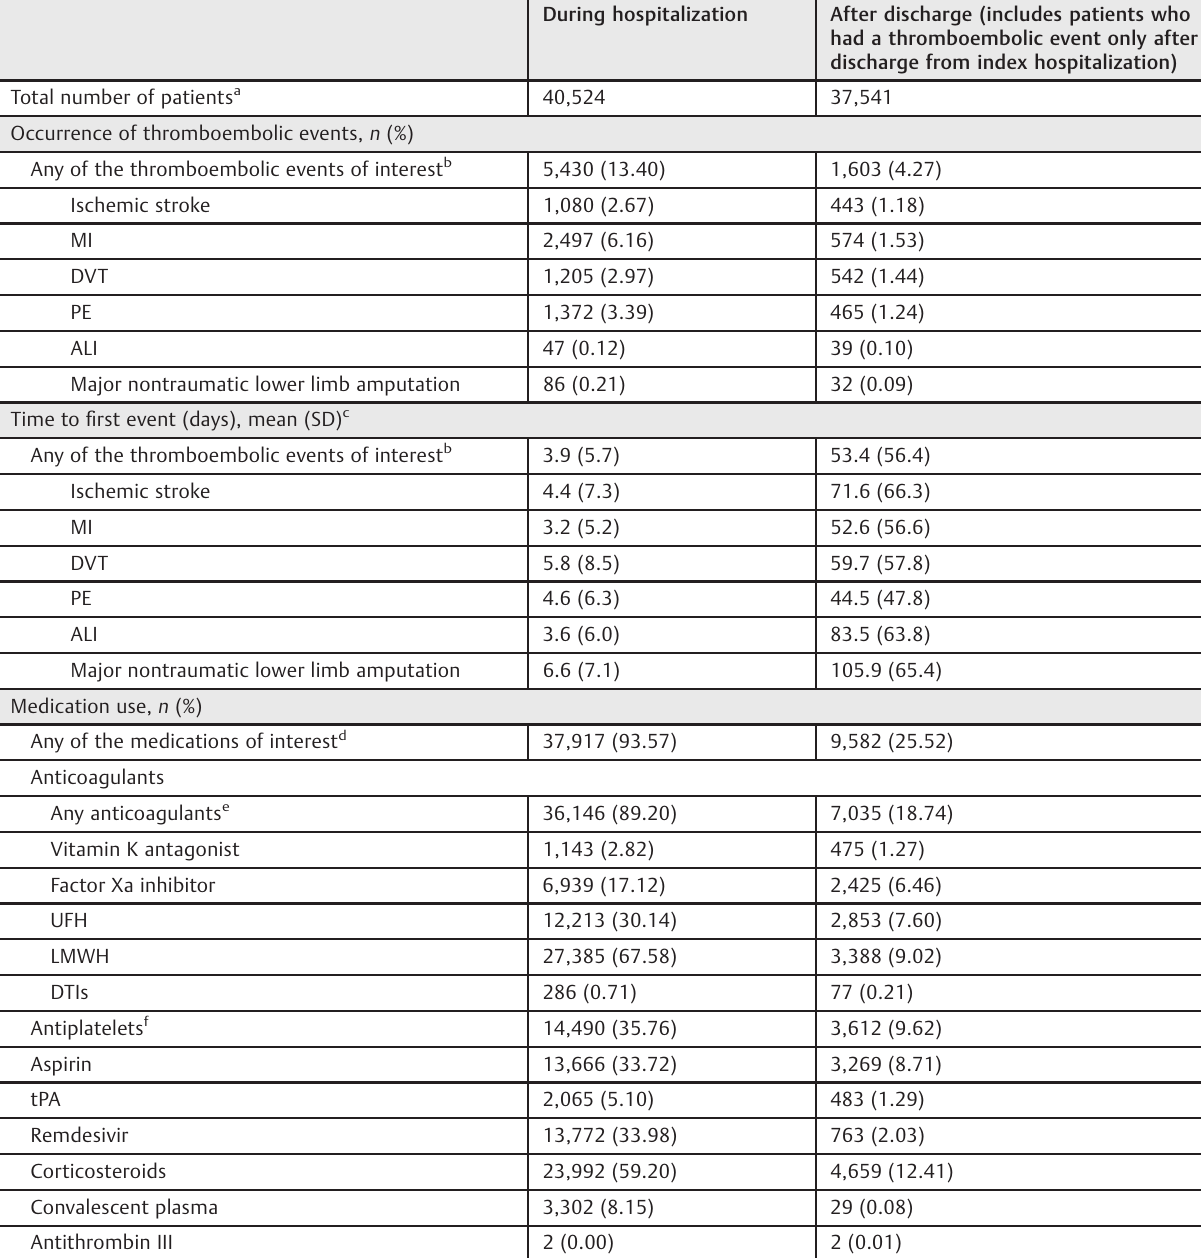
Table 5 Exploratory analysis: thromboembolic events and medication use during hospitalization and after discharge (not mutually